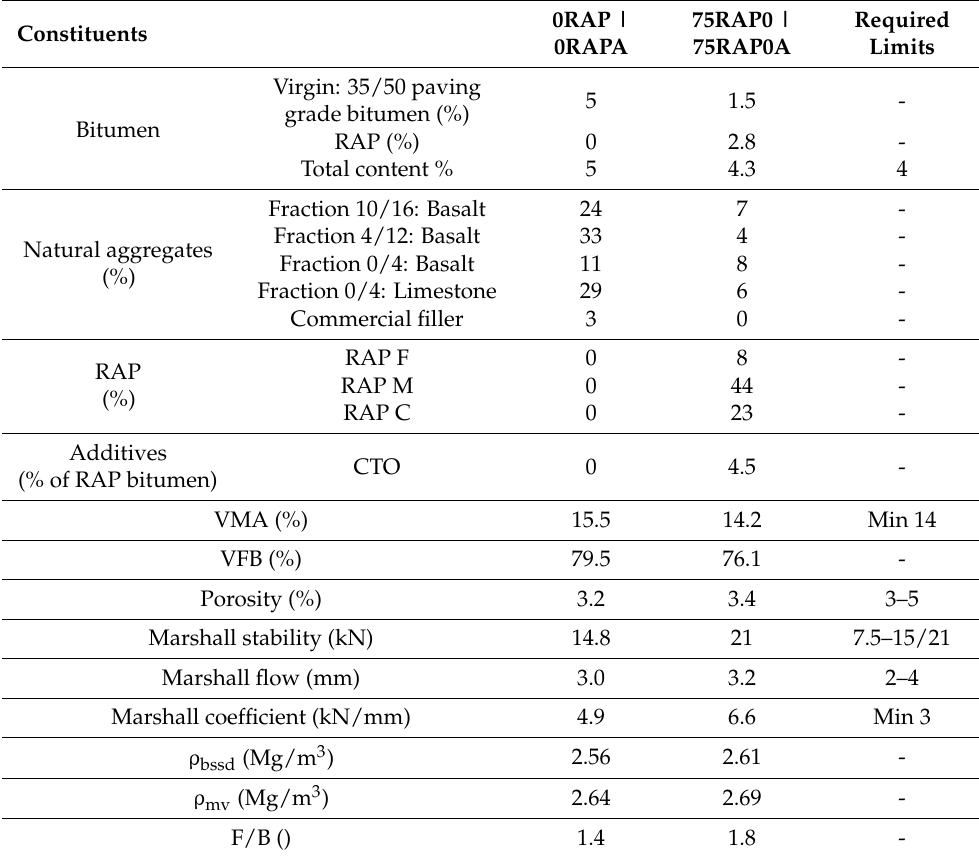
Table 3. Composition and properties of the bituminous